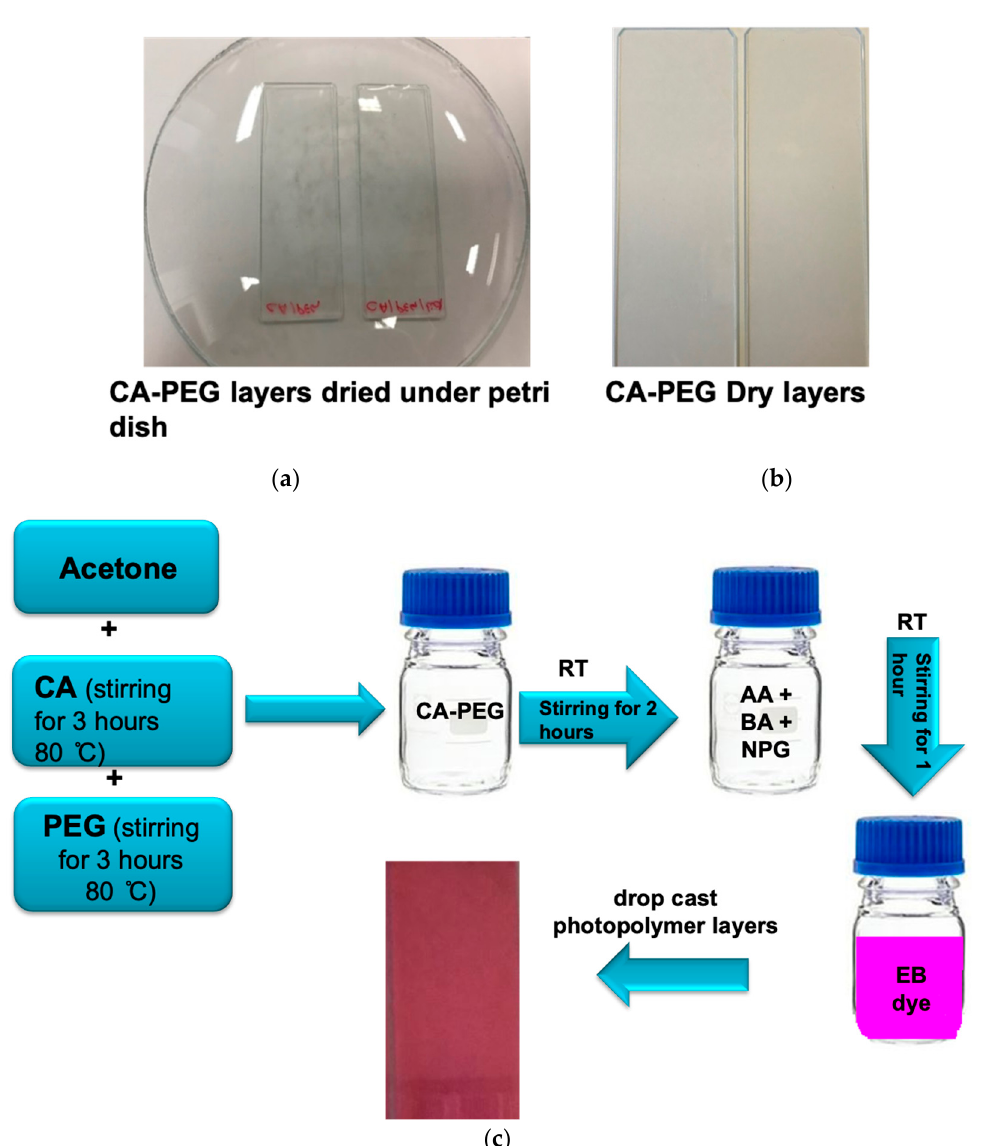
Figure 5. Pictures of ( a ) layers drying under a petri dish and ( b ) dried layers; ( c ) flow chart of photosensitized sample preparation.